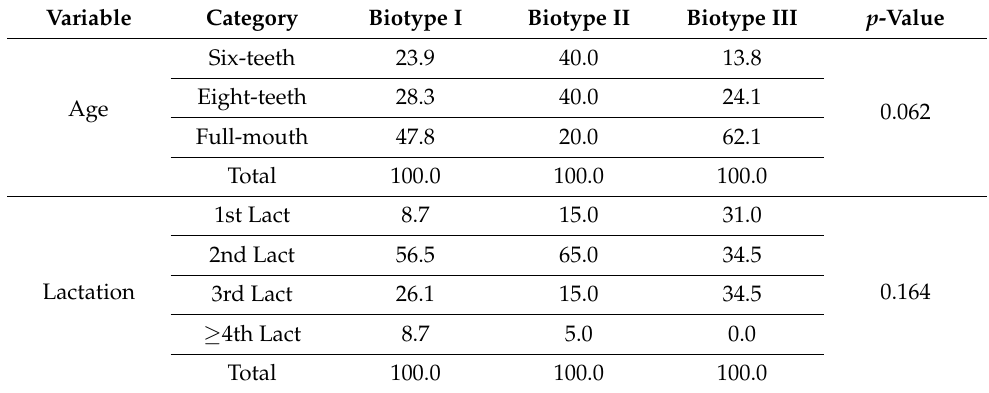
Table 9. Association of age and lactation with Creole cows biotypes (frequency values, %) 1 .